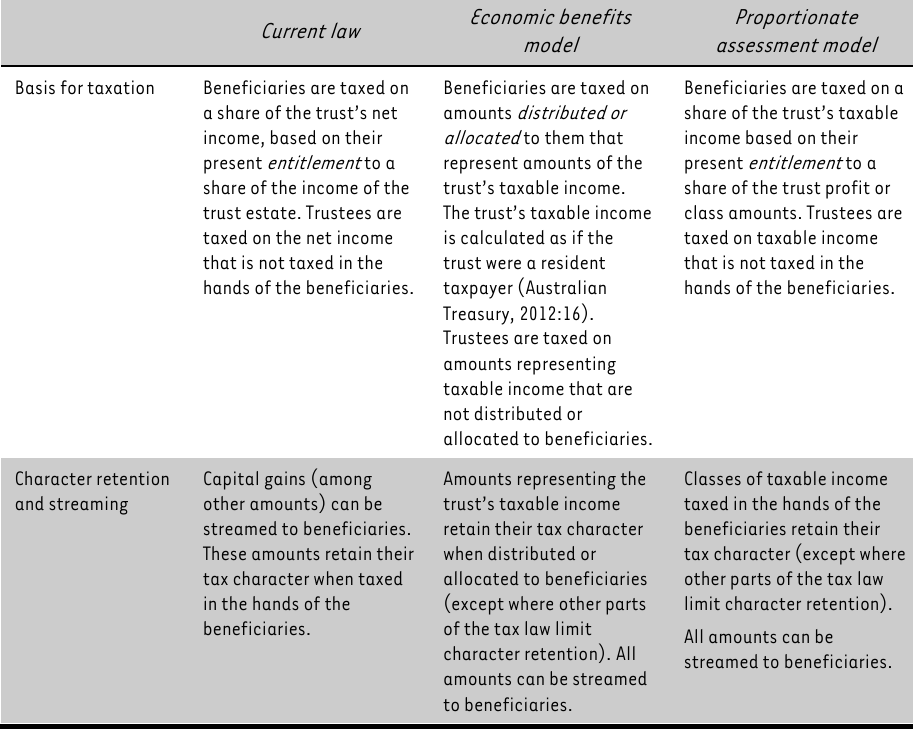
Comparison of current law with two proposed new models Current law